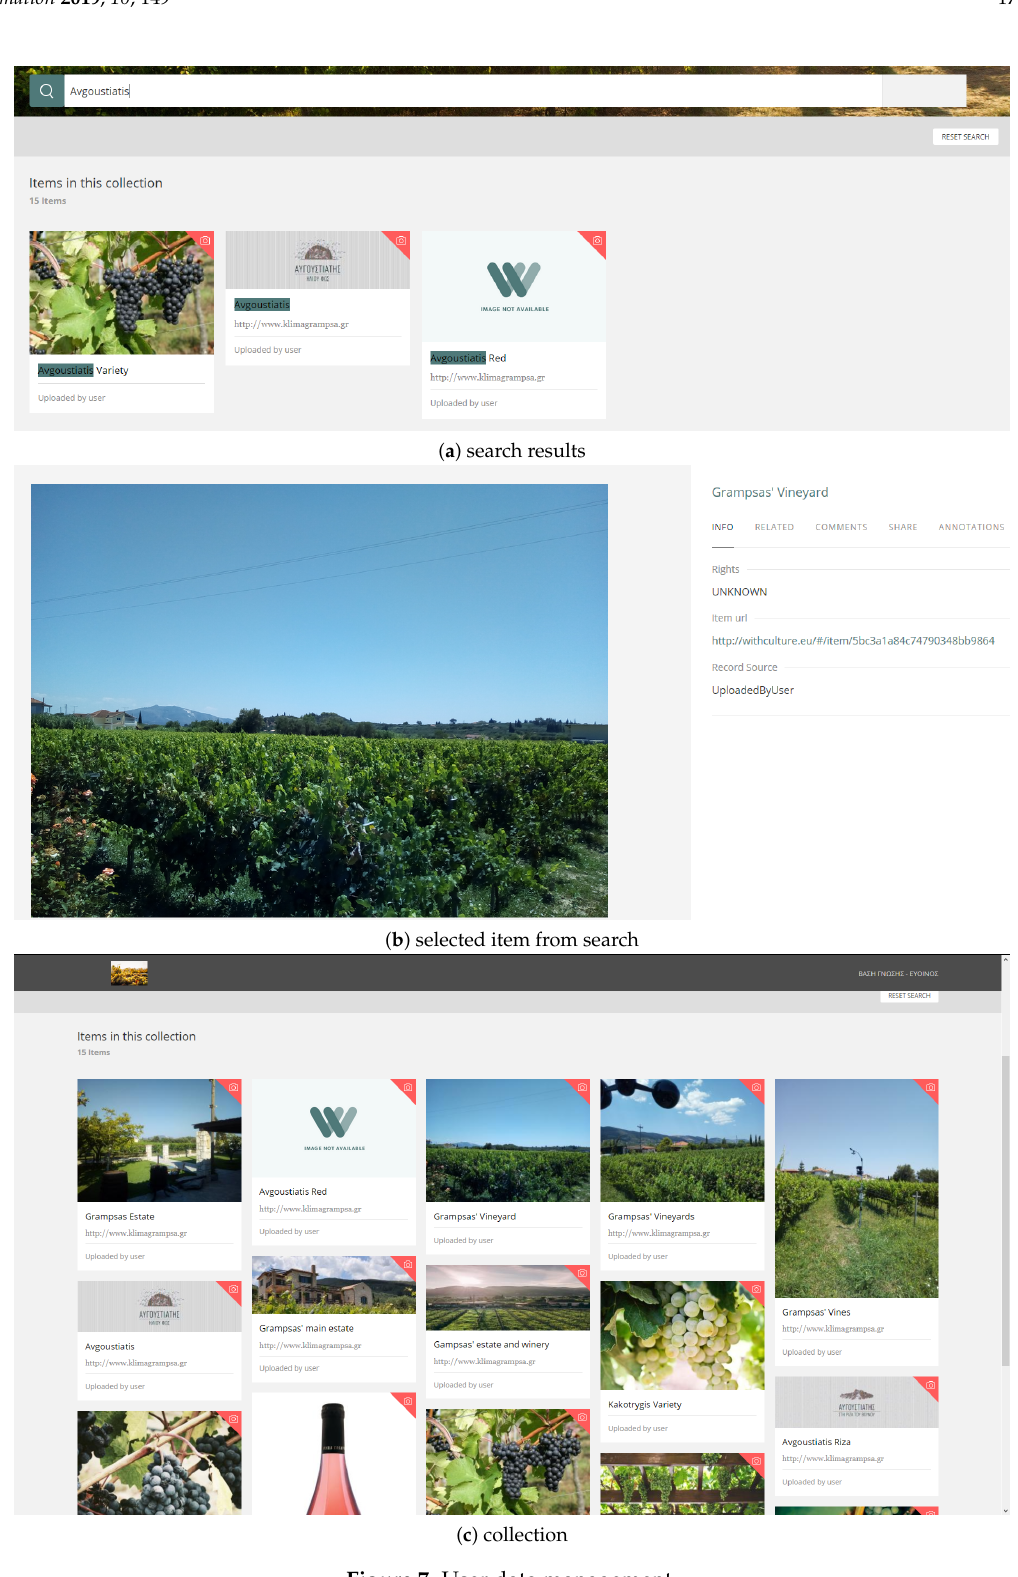
Figure 7. User data